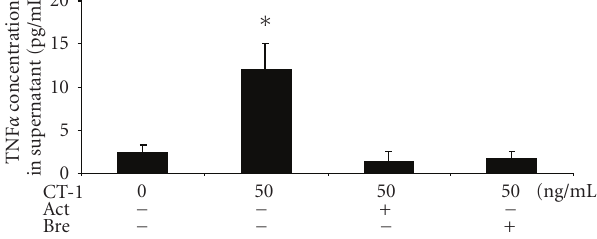
Figure 3: After 3 hours TNF α protein was determined by ELISA in the supernatant. CT-1 0ng/mL was set as 1. Act: actinomycin D (5 μ g/mL), inhibits mRNA transcription, Bre: brefeldin (10 μ g/ml), inhibits intracellular protein transport. n = 6, data are expressed as mean ± SEM. ∗ P < . 05 compared to unstimulated cells.